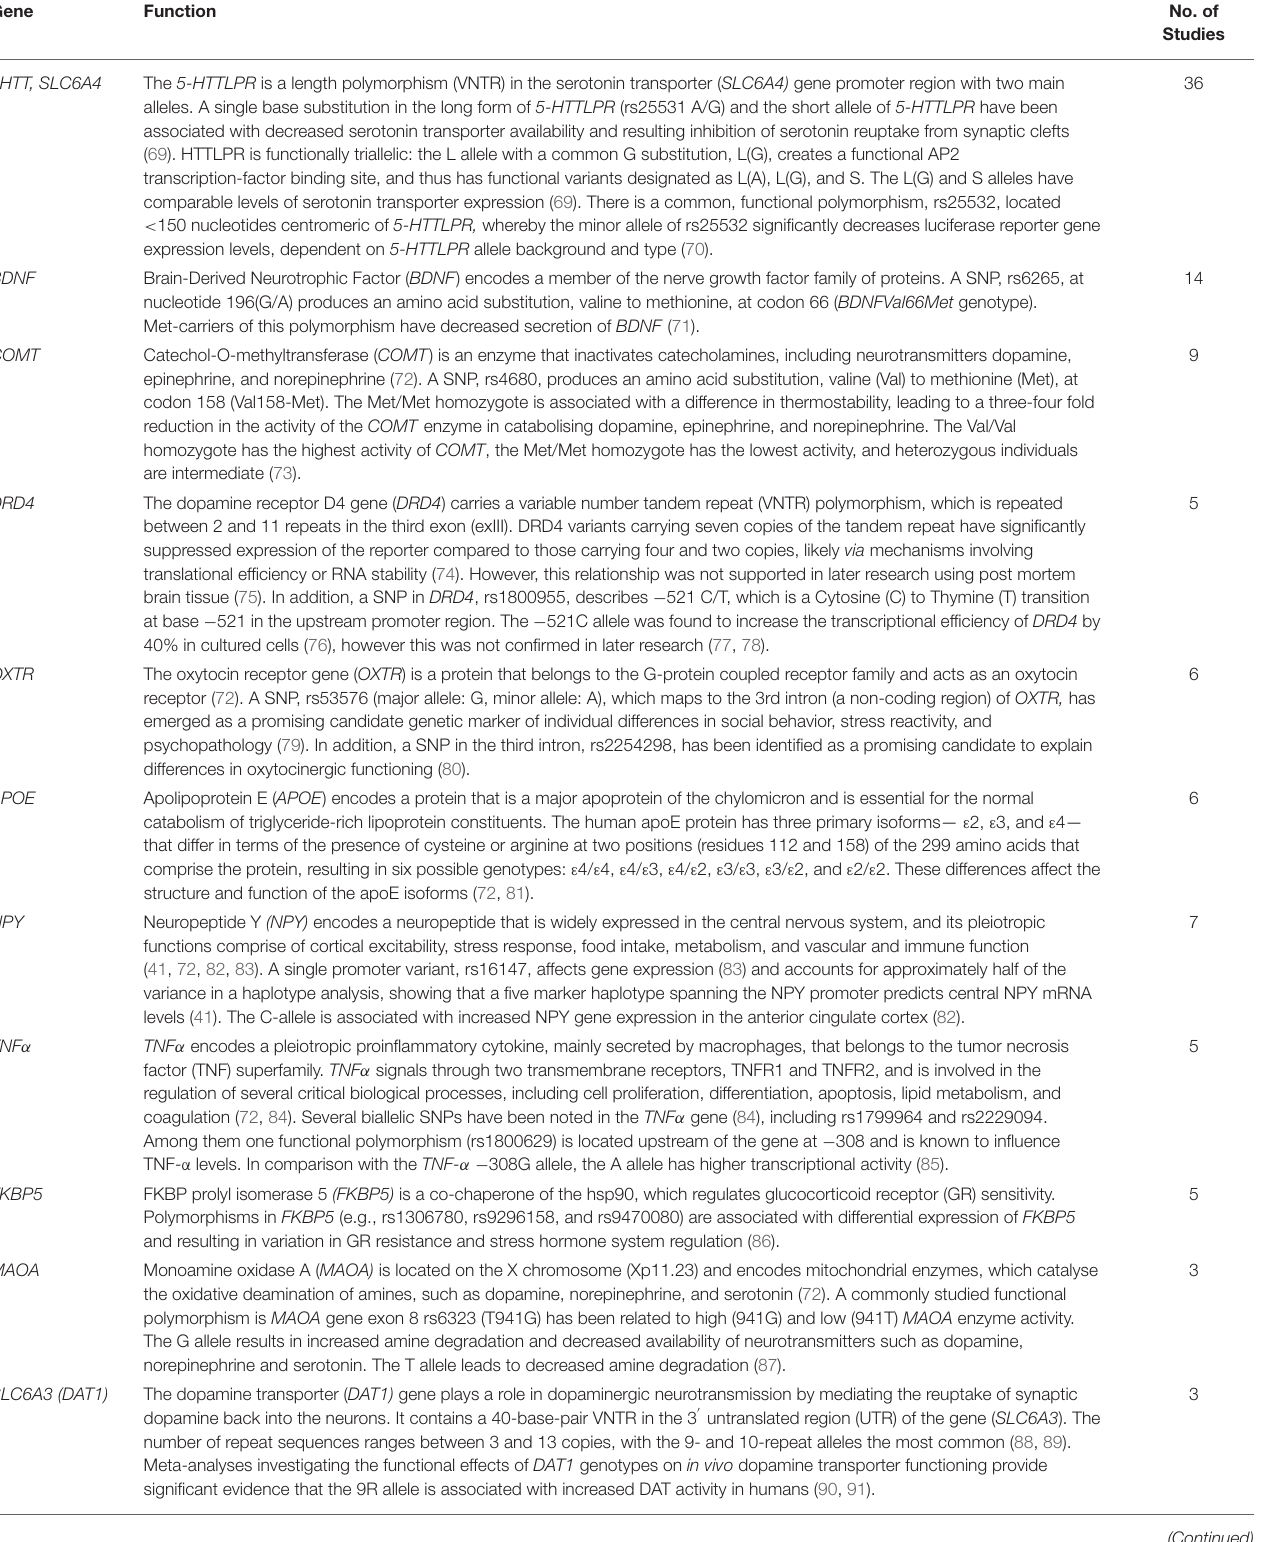
TABLE 1 | Gene functions for each gene identified in the systematic review with two or more studies reporting association with resilience. Gene Function No. of